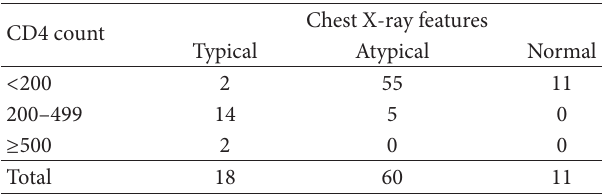
T 1: Characteristics of the patients in the study. Characteristics of the patients